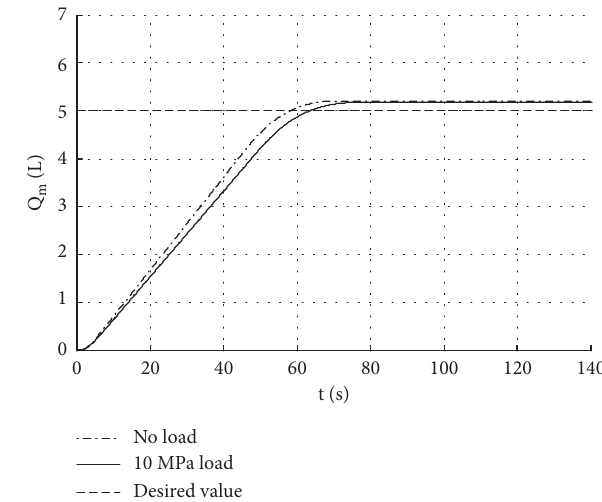
Figure 4: PID control system response curve without